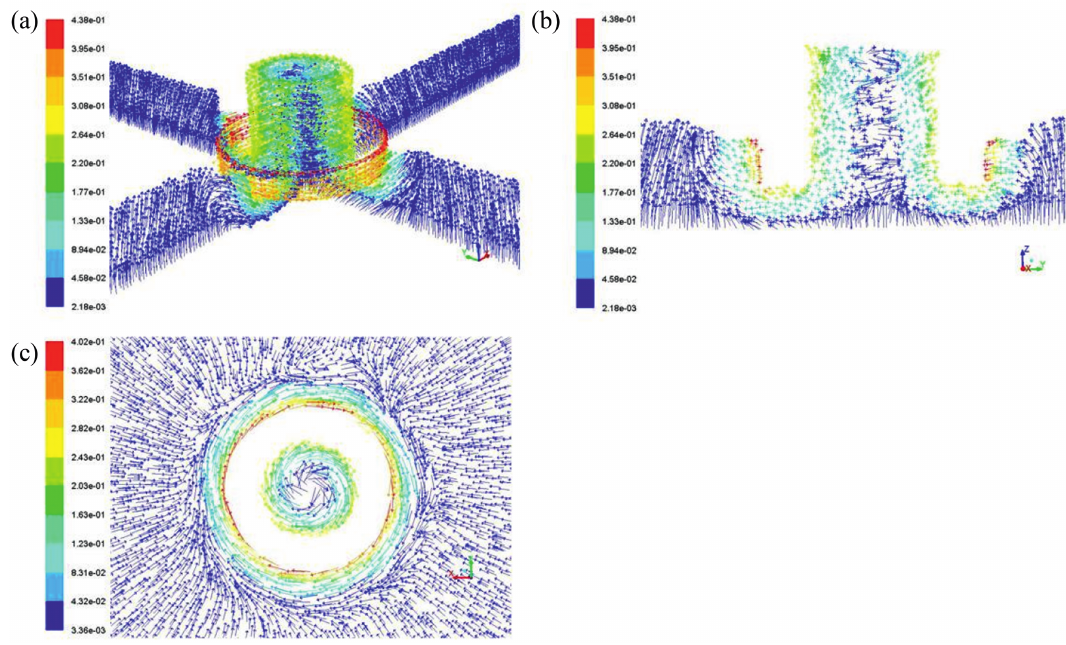
Figure 6: Material flow behavior at the plunging stage (1,000rpm and 4mm/s): (a) three-dimensional, (b) section a and (c) section